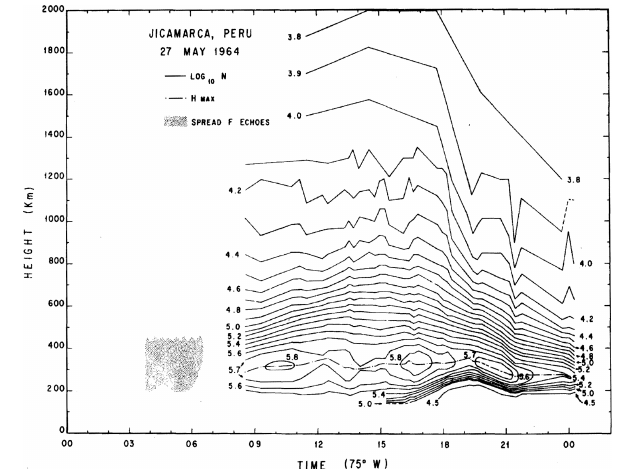
Figure 20. A contour plot of electron density as a function of height and local time, measured on 27 May 1964 (reproduced from Farley and Bowles,